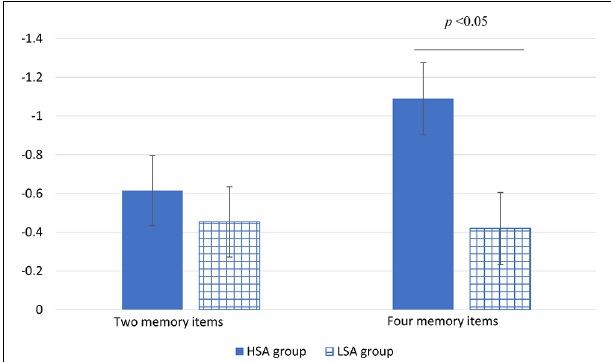
FIGURE 3 | The mean amplitude of CDA in high (HSA) and LSA groups under different numbers of memory item conditions (the vertical bars extend and below the mean by one stand